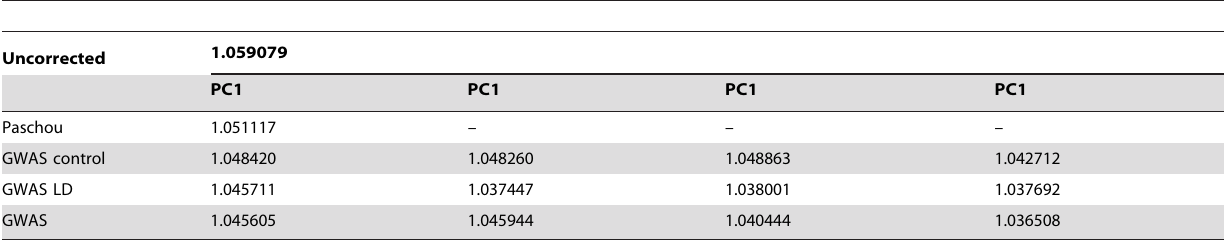
Table 2. Inflation factors in genomewide ovarian cancer association testing before (uncorrected) and after controlling